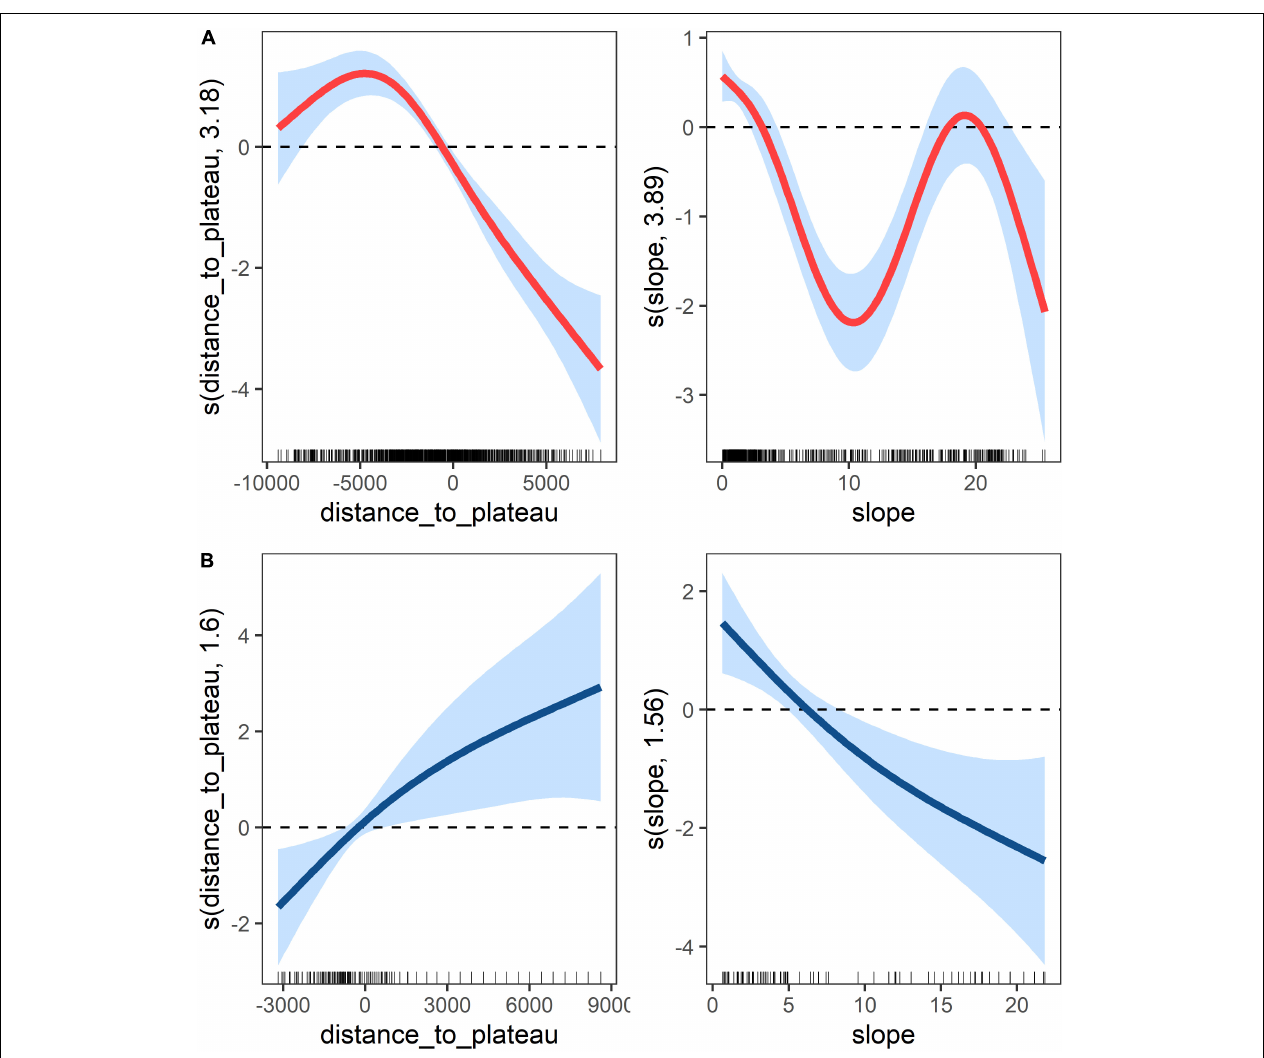
FIGURE 6 | Smooths of generalised additive model terms showing the effect of slope (degrees) and distance from the plateau edges (metre; the negative values are distances from the edges of the plateau to the centre of the seamount and the positive values are distances from the edges of the plateau going toward the open ocean) on the backscattering at 70 kHz for the shallow seamounts (McNish, RSA, Yakhont, Crawford West; (A) and the deeper seamounts (un-named, Crawford east; (B) . The solid lines are the estimates of the smooths, the thick marks on the x-axis are observed datapoints and the shaded regions indicate 95% confidence